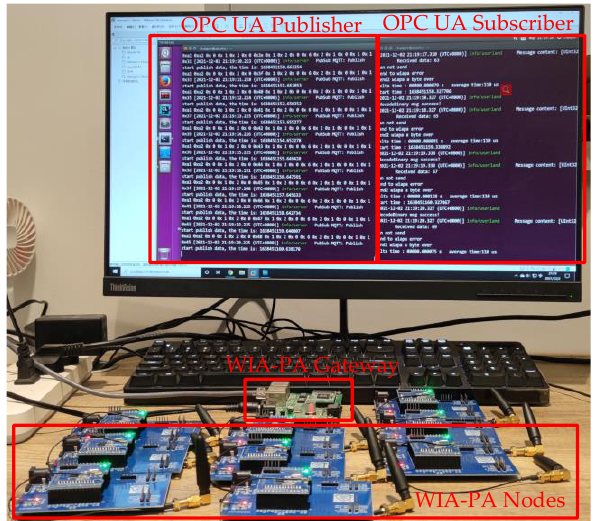
Figure 12. WIA-PA/OPC UA joint pub/sub experimental verification system.